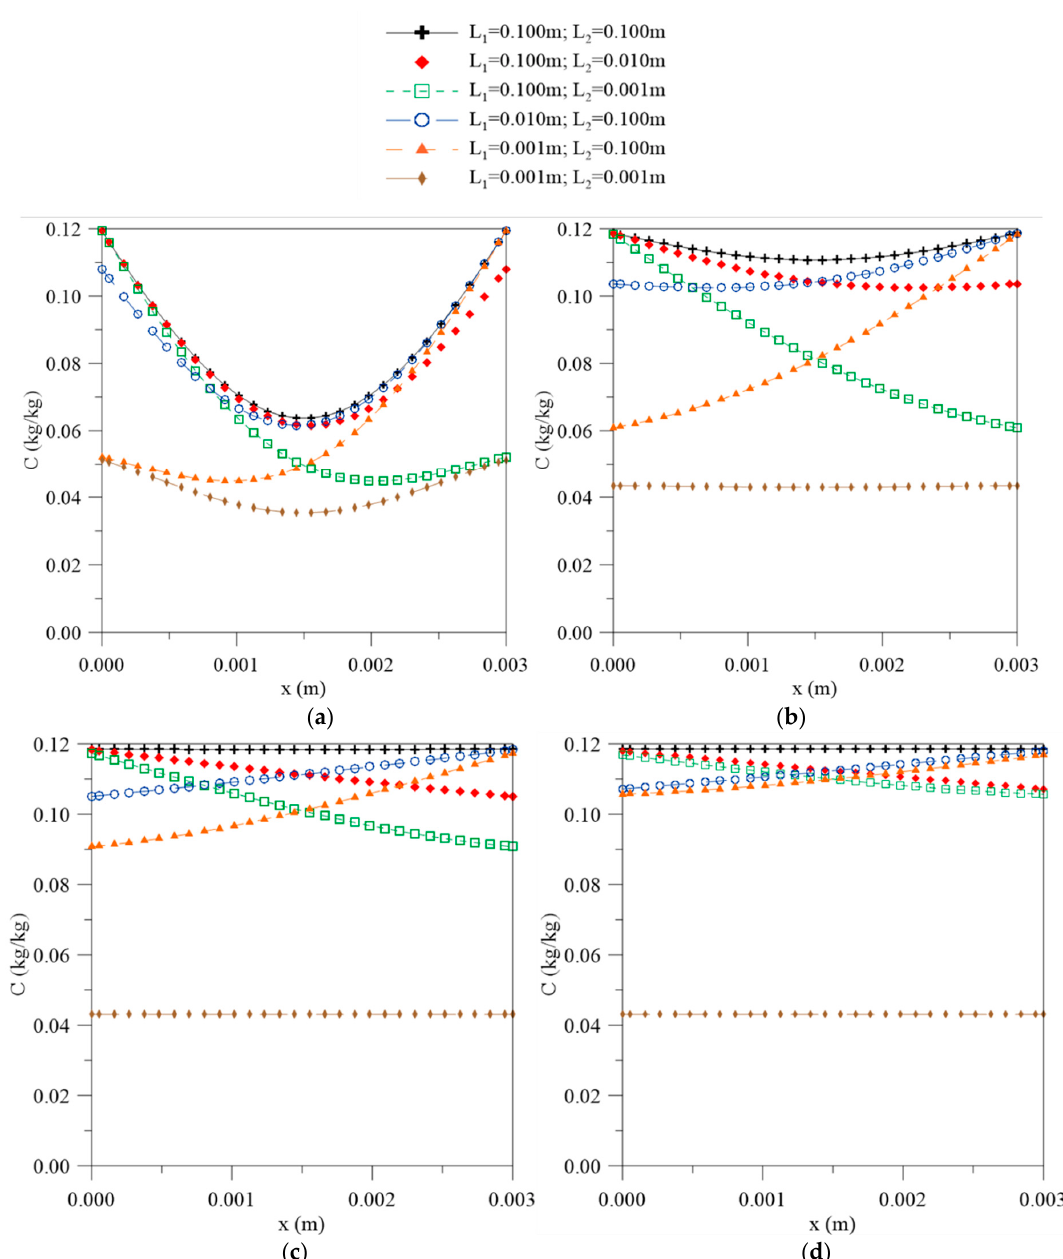
Figure 5. Free water molecule concentration as a function of the position inside the material at different process times: ( a ) 56, ( b ) 195, ( c ) 500, and ( d ) 1944 h.